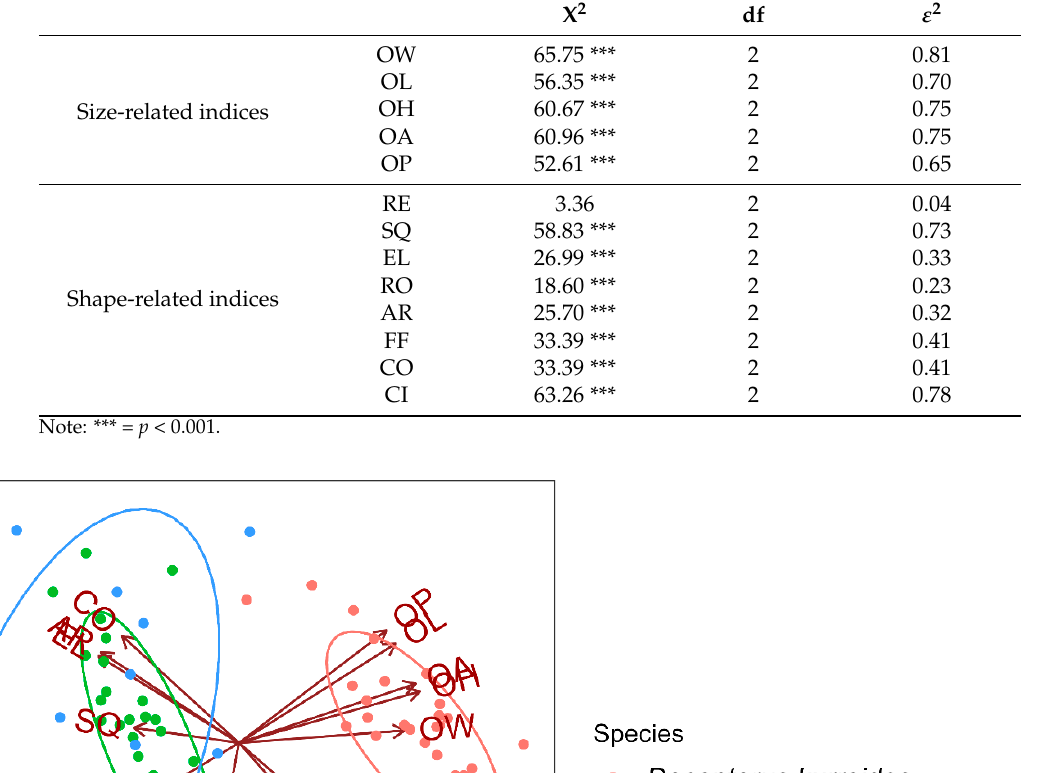
Table 3. Summary table for Kruskal–Wallis test using the size- and shape-related morphometric. Indices from the three redfin Decapterus species from the Sulu Sea, Philippines.